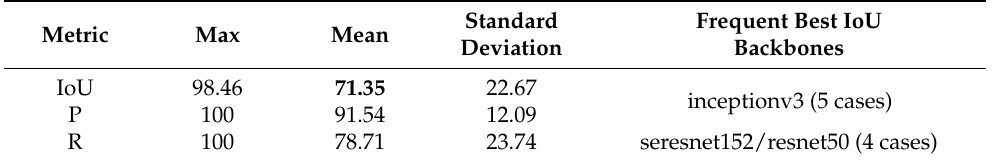
Table 3. Performance (%) of FPN on the test set after 5-fold cross-validation. Best mIoU is marked in bold.